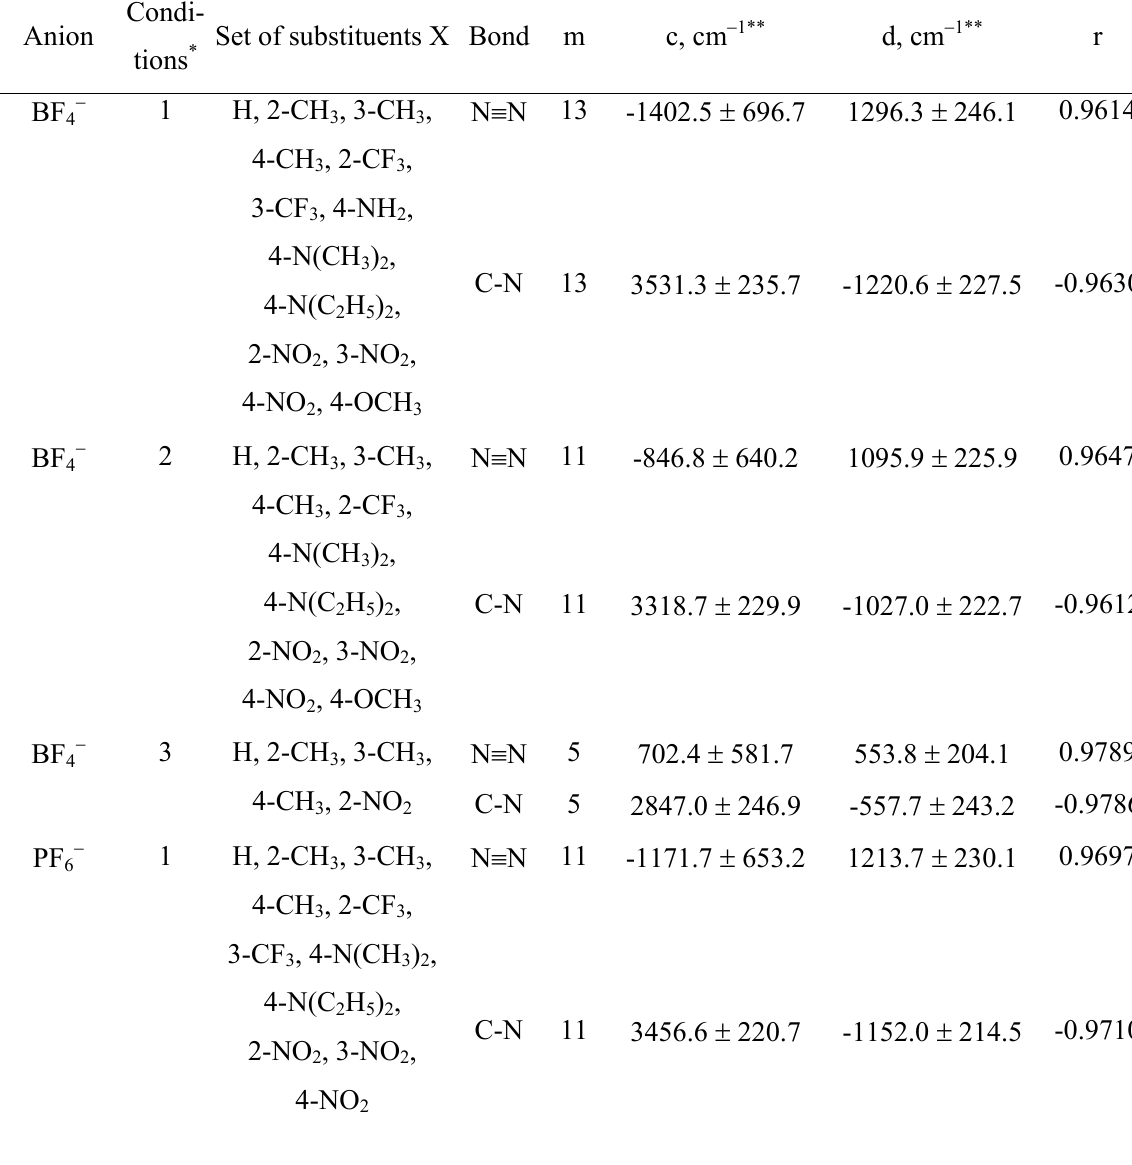
Table 3b. Correlations of stretching vibrational frequencies ( ν ) for fragment C-N + ≡ N bonds